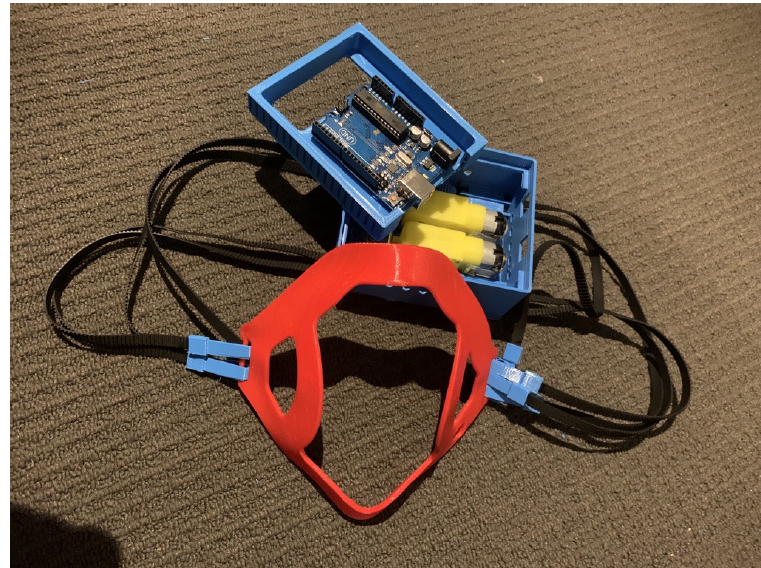
Figure 8. Prototype 3D-printed automatically adjusting smart